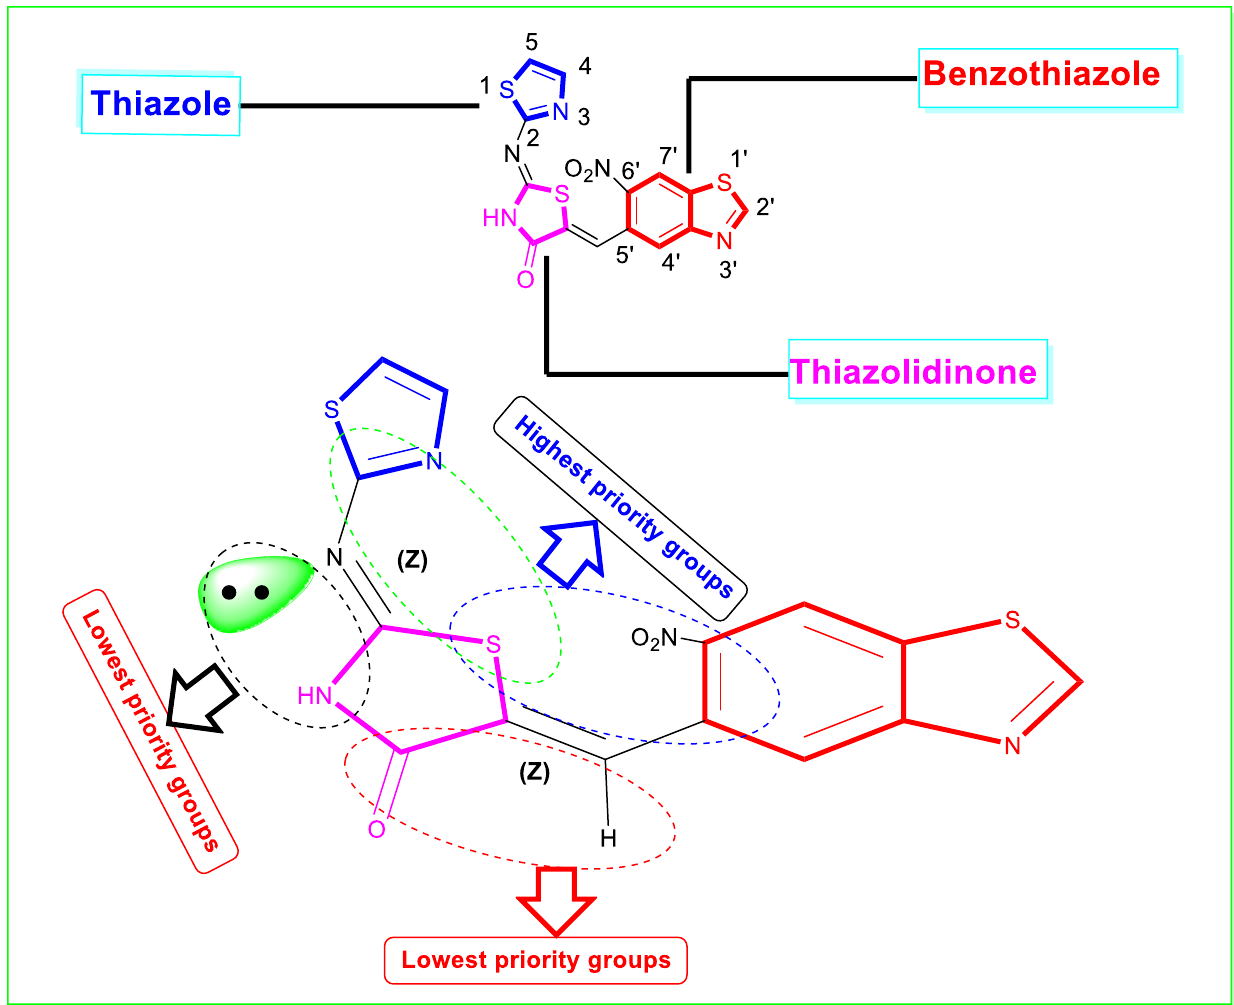
Figure 2. The general representation of (2Z,5Z)-5-((5-nitrobenzo [d]thiazol-6-yl) methylene)-2-(thiazol-2-ylimino)thiazolidin-4-one ( 1 ).